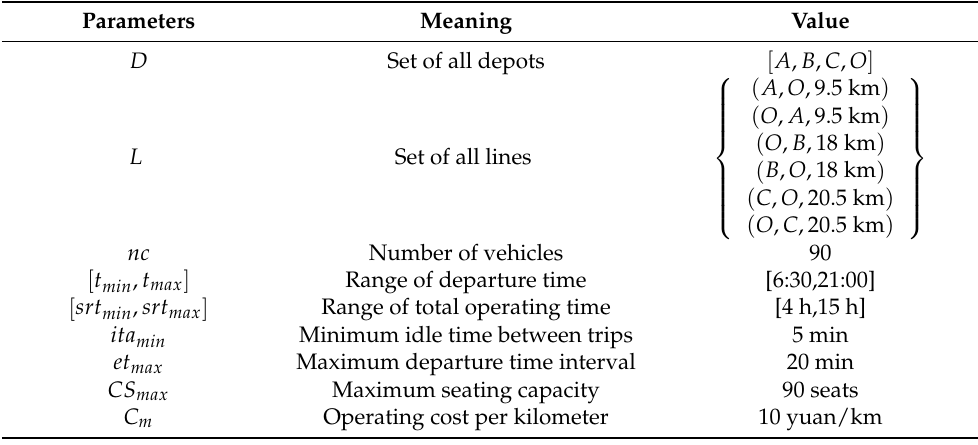
Figure 10. Trip run time data of different lines. Table 3. The values of